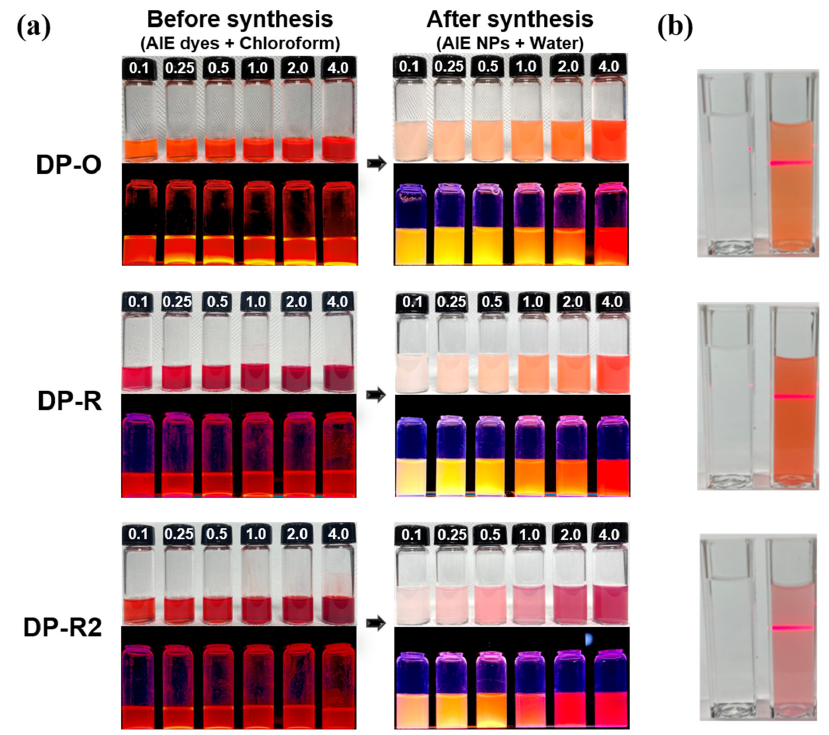
Figure 5. ( a ) Photographs before and after fabrication of DPP ‐ based AIE NPs. ( b ) Tyndall phenomenon by AIE NPs under laser irradiation, the left cuvette is pure water, and the right cuvette is AIE NPs solution.